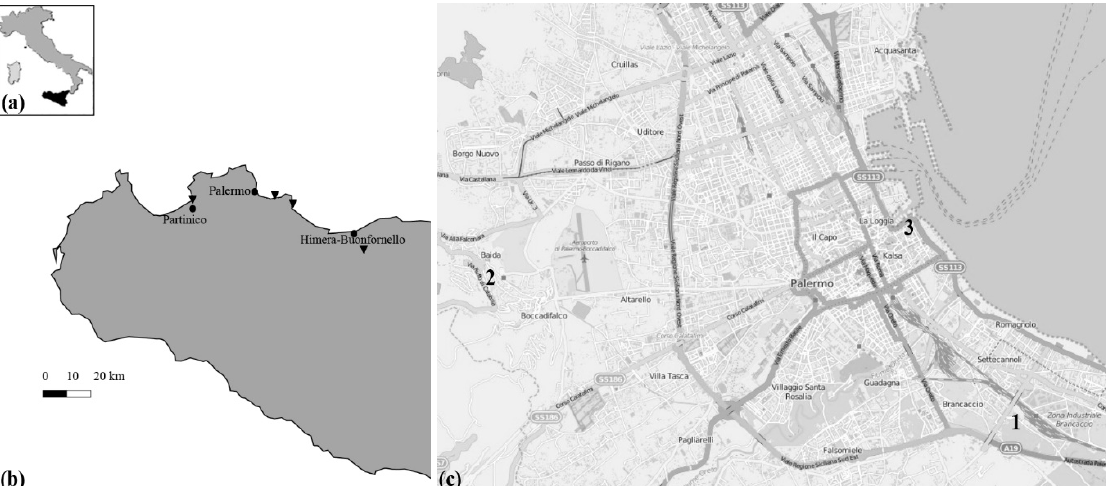
Figure 2. Map of Italy ( a ); western Sicily with the site discussed ( b ) (black dots: site sampled, black triangles: geological deposits sampled); and map of Palermo ( c ), with the sites discussed in the text. 1: Castello della Favara in Maredolce, 2: Convento di Baida, 3: Palazzo Steri–Chiaramonte.